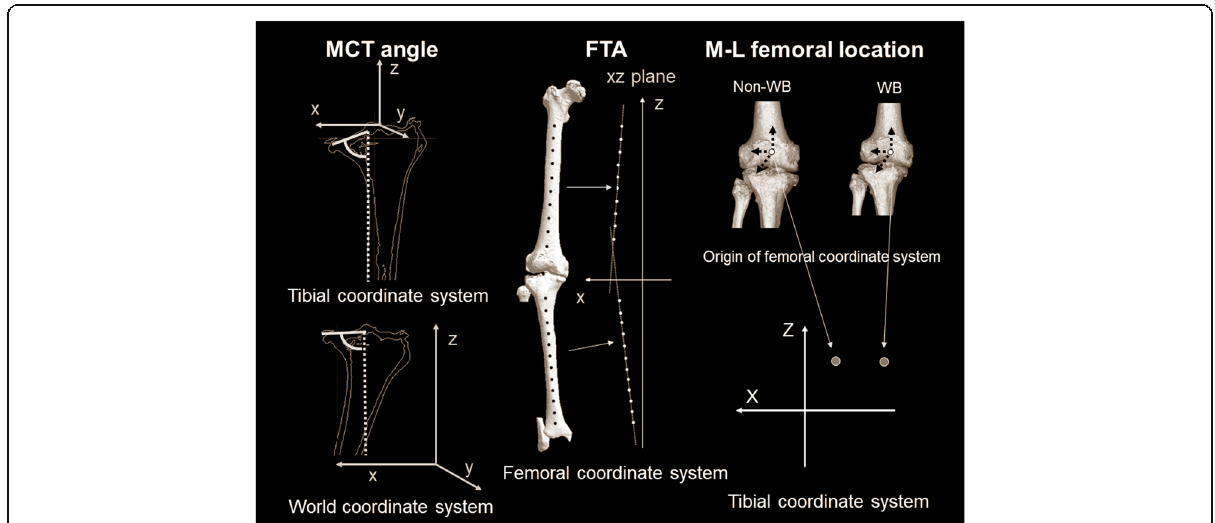
Fig. 4 Schematic diagram showing the MCT angle, FTA, and M – L femoral location. MCT angle under non-WB conditions in the tibial coordinate system was defined as the angle between the tangential line of an articular surface in MCT and the z -axis of the tibial coordinate system. As the assessment plane, the coronal plane passing the tibial coordinate system origin point was used. MCT angle under WB conditions in the world coordinate system was defined as the angle between the tangential line of an articular surface in the MCT and the z -axis of the world coordinate system. As the assessment plane, the coronal plane passing the middle section between the anterior- and posterior-most points of the medial compartment in the world coordinate system was used. In terms of FTA, the anatomic longitudinal axes were defined as a regression line obtained from approximating distances from these 10 centroids in the femur and 12 centroids in the tibia by the least squares method, respectively. FTA was assessed as the angle between the anatomic longitudinal axes of the femur and tibia in the coronal plane of the femoral coordinate system. Regarding M – L femoral location, the M – L location of the femur relative to the tibia was defined as the location of the origin point of the femoral coordinate system, and was assessed in the coronal plane of the tibial coordinate system